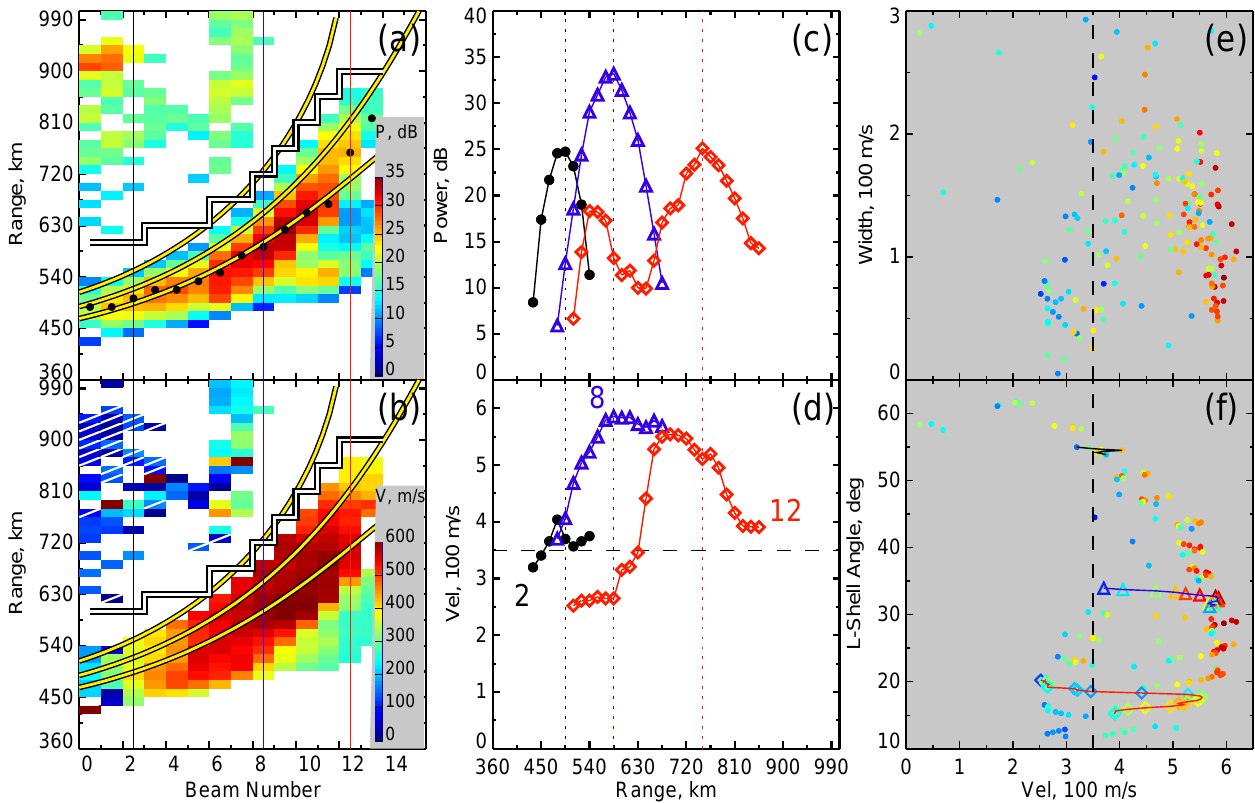
Fig. 2. Panels (a) and (b ) show, respectively, the spectral power and Doppler velocity maps for 21:16–21:18UT on 24 February 1997. The cells with white diagonal in panel (b) represent negative velocities. The black-white line indicates the chosen boundary between the F- and E-region backscatter bands. The coloured vertical lines show the 3 selected beams. The black dots show the power maxima along each beam. The thick yellow curves are the lines of zero aspect angle at an altitude of 110km assuming electron density profiles with the density maxima (3.7, 4.2, 4.7) × 10 4 cm − 3 for the top, middle and bottom curves, respectively. Panels (c) and (d ) show, respectively, slant range profiles of the spectral power and velocity along the 3 selected beams. The digits show the beam numbers. The vertical dashed lines show the range of maximum power along each beam. Panels (e) and (f ) are the scatter plots of (e) the spectral width and (f) the L-shell angle versus velocity. The data points are colour-coded in spectral power as given by the colour bar in panel (a). The horizontal dashed line in (c) and (d) and vertical dashed line in (e) and (f) show the nominal ion-acoustic speed of 350m/s. The coloured lines in (e) and (f) connect the data points for the 3 selected beams (the same as in panels c and